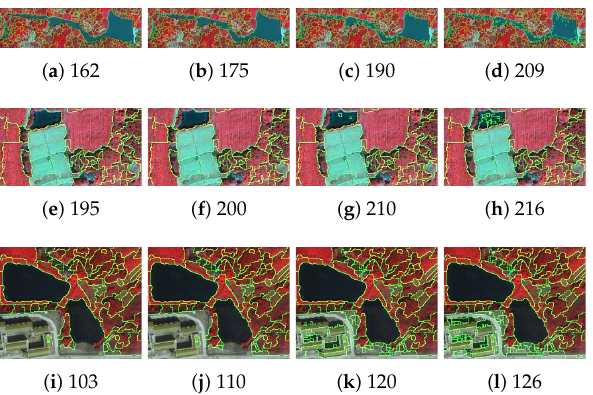
Figure 7. Segmentation by setting four different threshold applied for generating spectral-index markers based on NDWI.